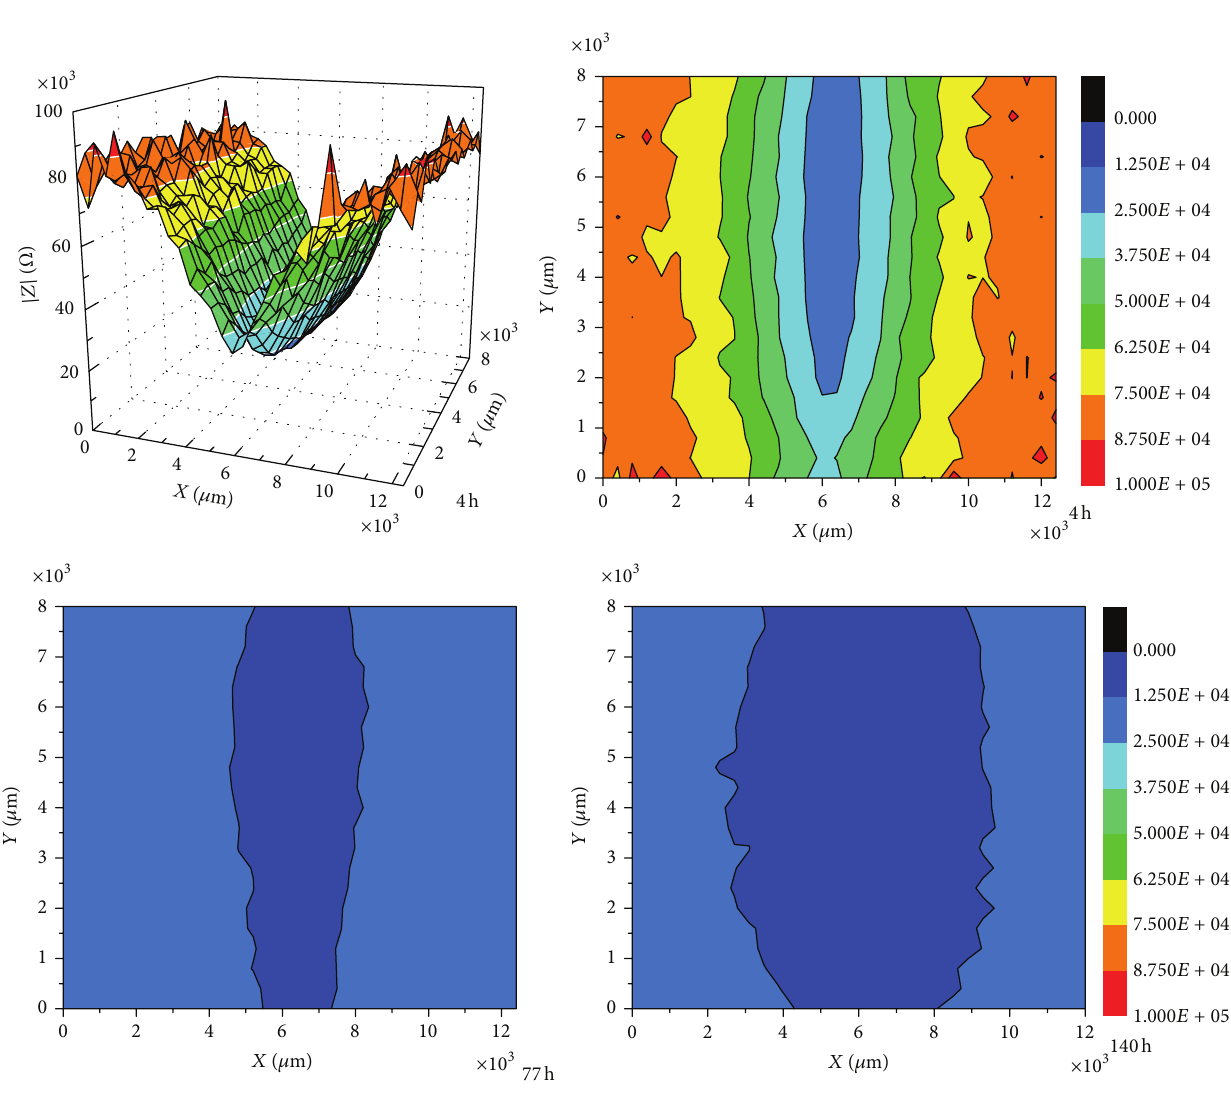
Figure 9: Time dependence of LEIS profiles and their projections of epoxy antirust painted